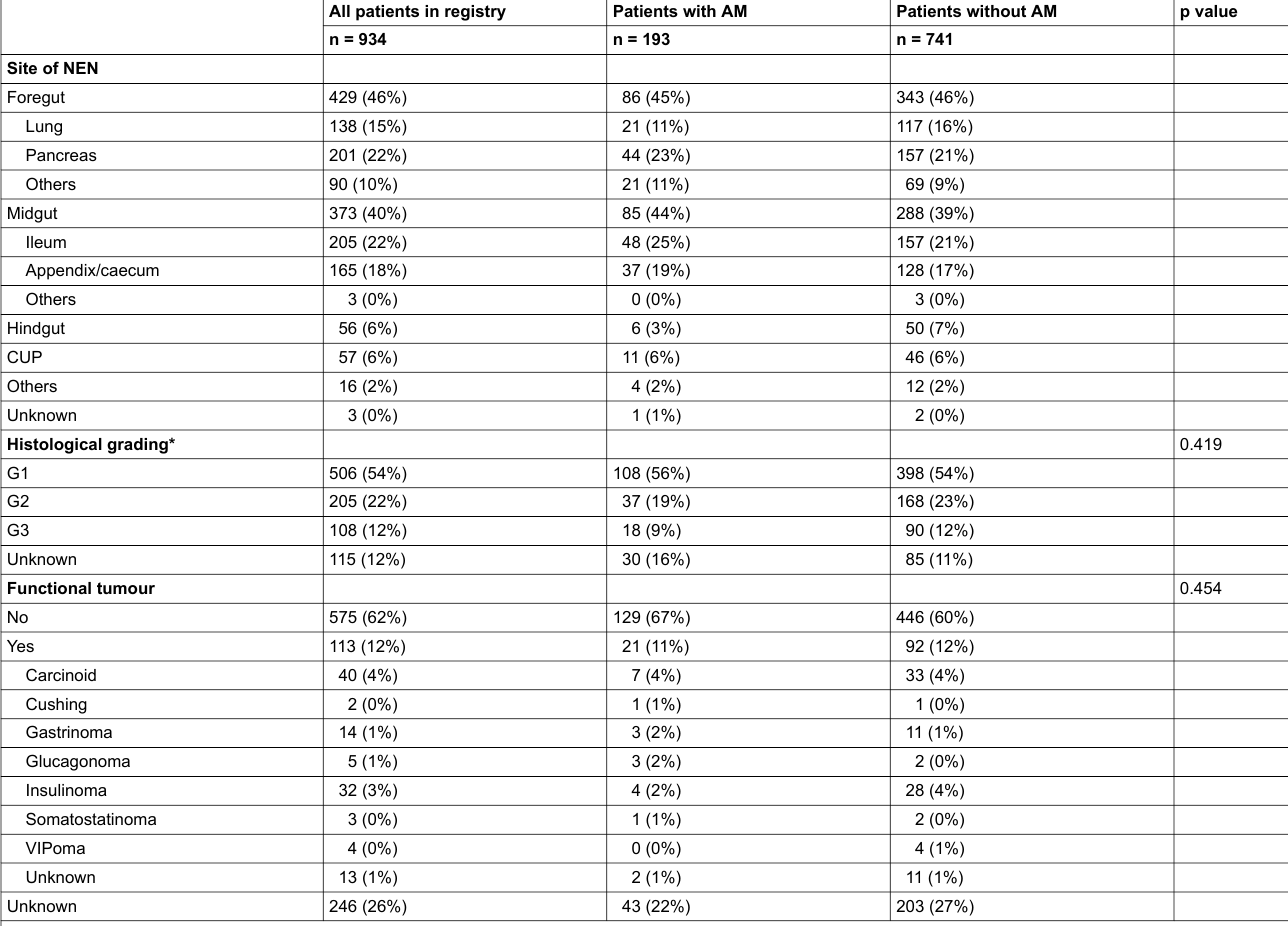
Table 2: Clinical characteristics of neuroendocrine neoplasms for patients with and without additional malignancies. All patients in registry Patients with